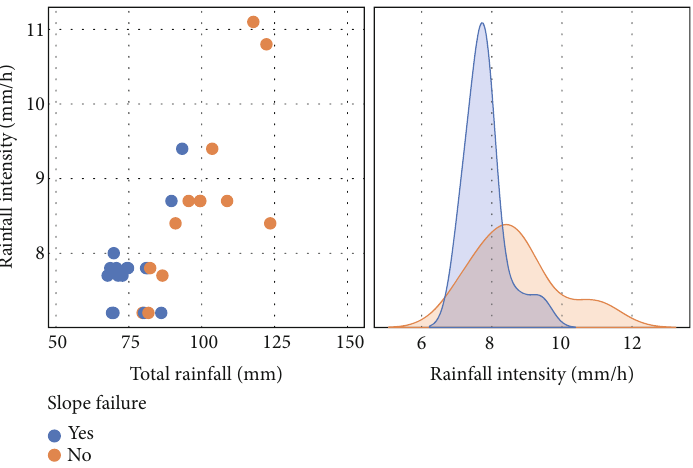
Figure 12: Slope failure vs. total rainfall and